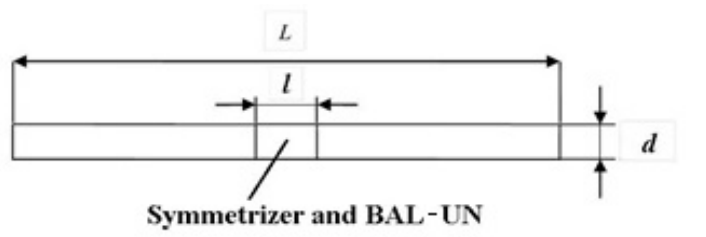
Figure 3. The dimensions of the emission